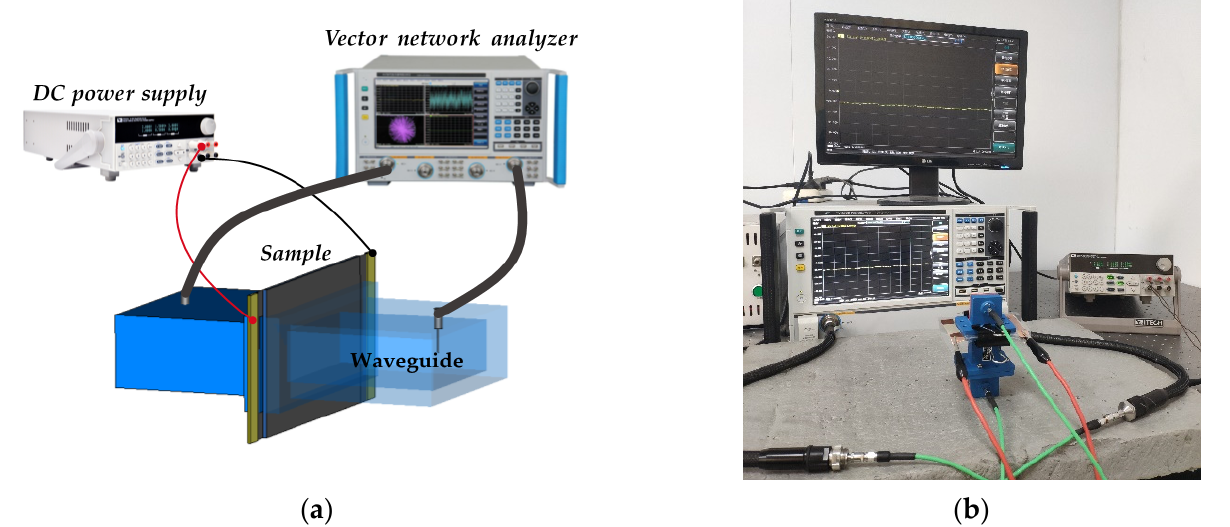
Figure 4. ( a ) The schematic and ( b ) experimental setup of waveguide testing method.